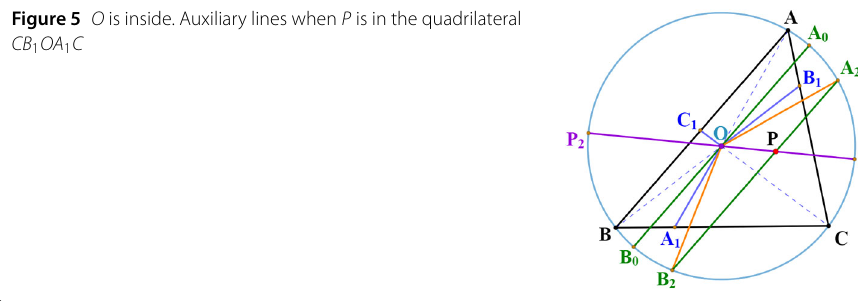
Figure 5 O is inside. Auxiliary lines when P is in the quadrilateral